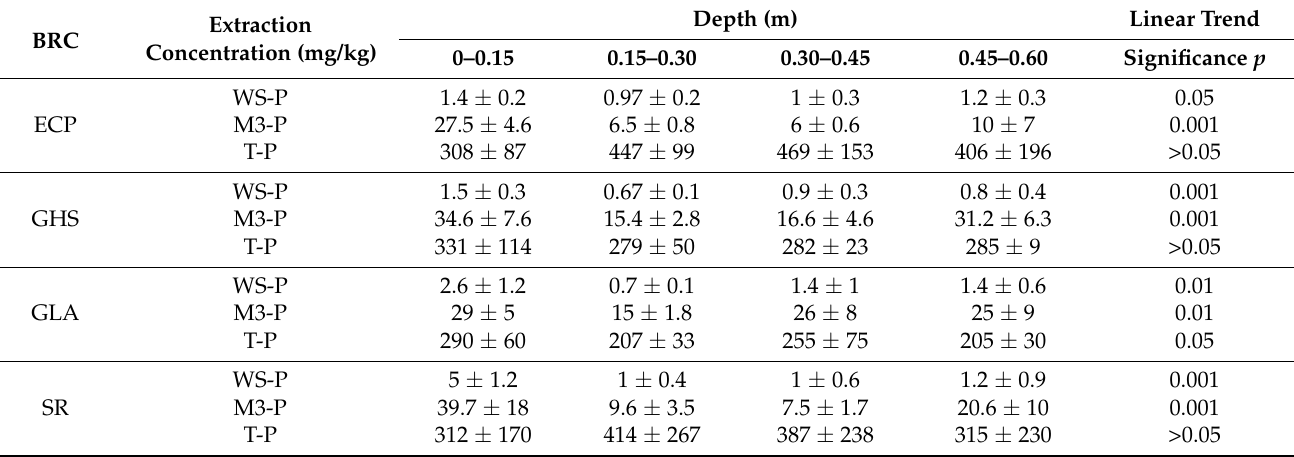
Table 6. Phosphorus concentration and standard deviation by extraction method and significance level of linear reduction with depth after seven years of operation ( p ).